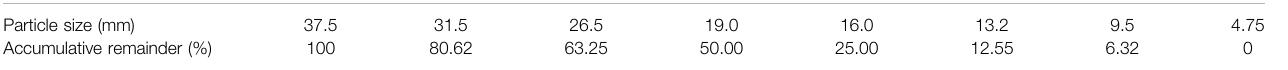
TABLE 1 | Grading of the recycled aggregate.